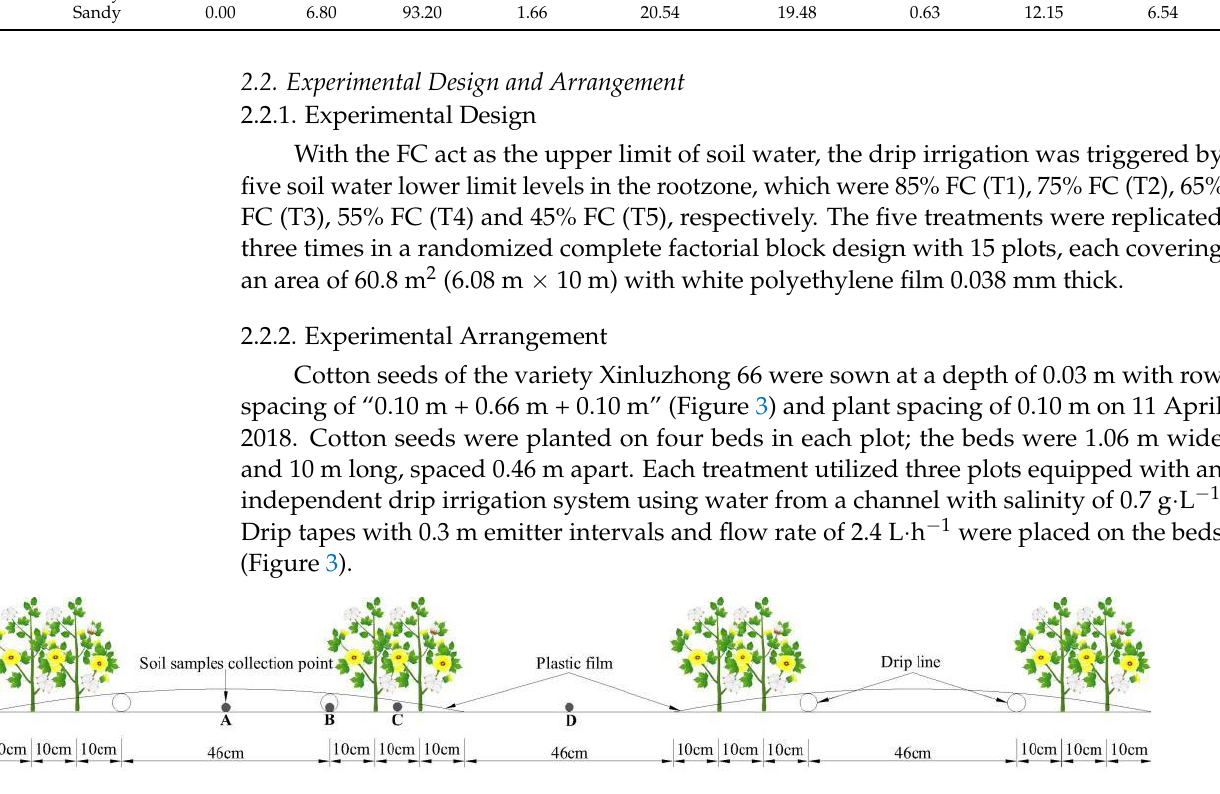
Figure 3. Experimental setup and sampling locations.